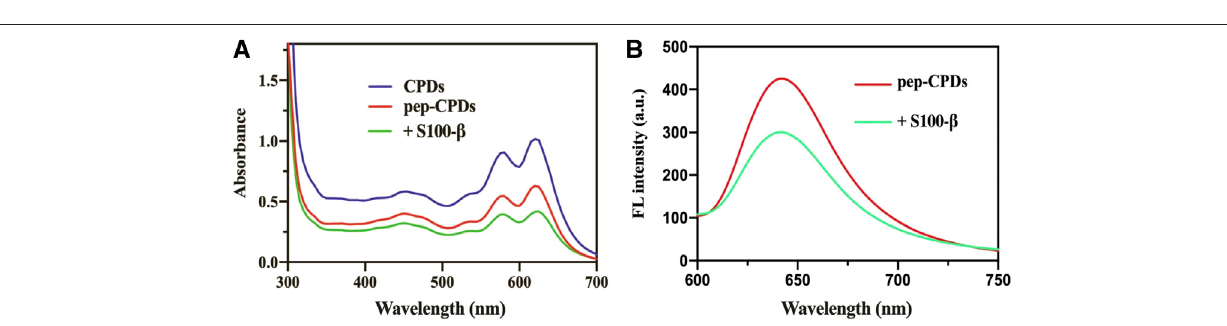
FIGURE 1 | (A) . UV-Vis absorbance spectrum of CPDs (blue line), pep-CPDs (red line), and its addition of S100- β (green line) (B) . Fluorescence spectra of pep- CPDs in the presence and absence of S100- β . λ ex = 520